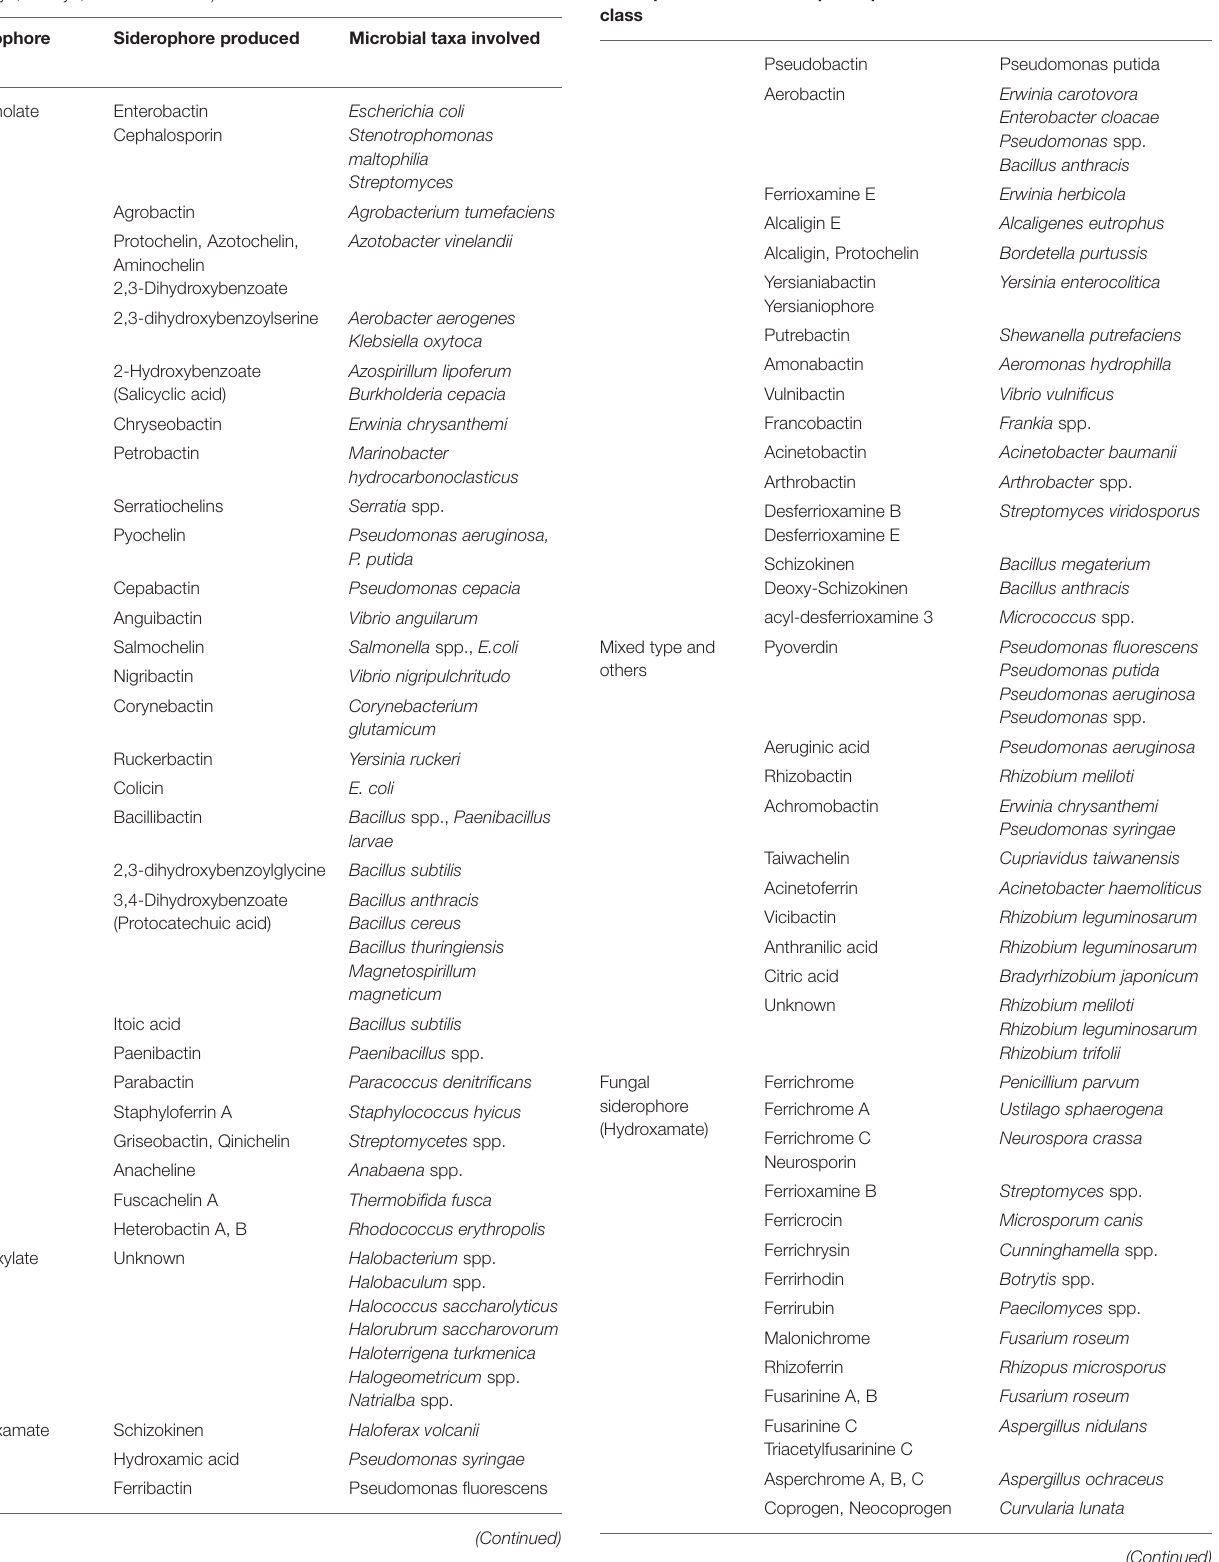
TABLE 4 | Microbial members responsible for producing/secreting several siderophores identified from various metabolite databases (SiderophoreBase, MetaCyc, BioCyc, and